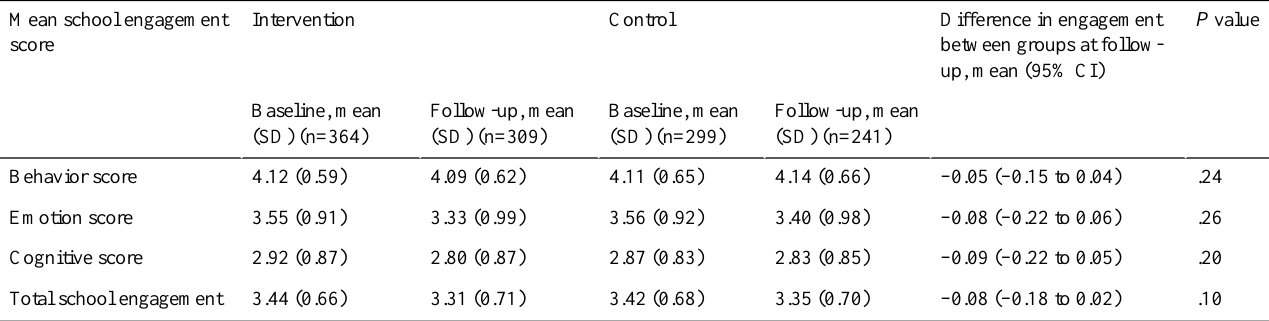
Table 3. Mean school engagement measure by group at baseline and at